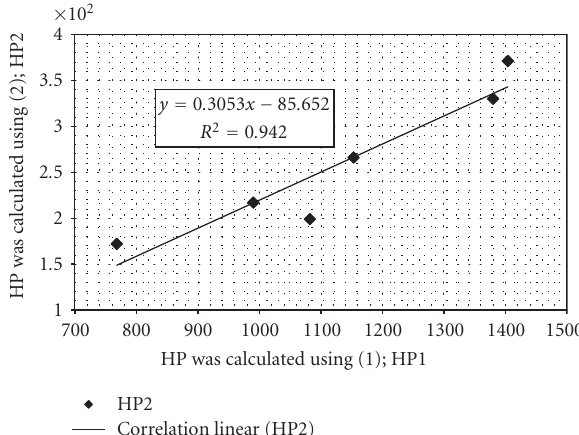
Figure 5: Correlation between the hardening power calculated by Segerberg’s equation for oil quenchants no agitation (HP1) and Segerberg’s equation for polymer quenchants with agitation (HP2).